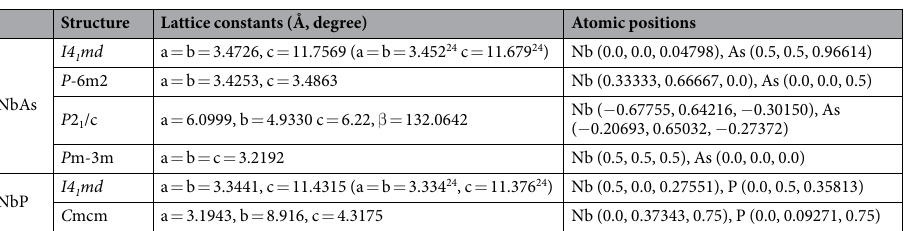
Table 1. Calculated lattice constants and atomic positions for different phases of NbAs ( I 4 1 md , P -6m2, P 2 1 /c, P m-3m) and NbP ( I 4 1 md and C mcm) at ambient pressure together with the experimental lattice constants of their I 4 1 md